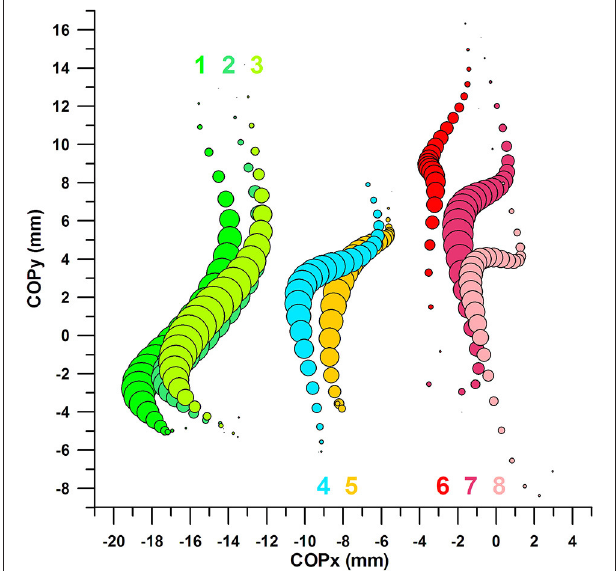
FIGURE 11 | Centre of pressure in y-direction (COPy) against Centre of pressure in x-direction (COPx); the bubble size of the 8 bubble plots corresponds to the impact force; the graphs are aligned to the coordinate system of the sensor matrix: positive COPy data = distal; negative COPy data = proximal; negative COPx data = medial; positive COPx data = lateral; the COP moves from distal to proximal ( = downward on the graph) during impact; 1: average COP of successful kicks, COPy and Fmax within the favorable range; 2: average COP of successful kicks, COPx and COPy within the favorable range; 3: average COP of successful kicks, COPx and Fmax within the favorable range; 4: average COP of all successful kicks; 5: average COP of all un successful kicks; 6: average COP of un successful kicks, COPy and Fmax within the un favorable range; 7: average COP of un successful kicks, COPx and COPy within the un favorable range; 8: average COP of un successful kicks, COPx and Fmax within the un favorable